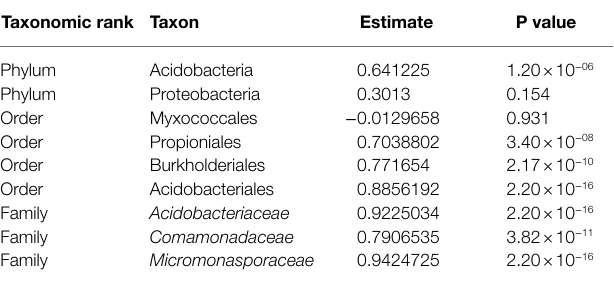
TABLE 2 | Pearson’s correlation estimates ( r ) between 16S and long read relative abundances. Taxonomic rank